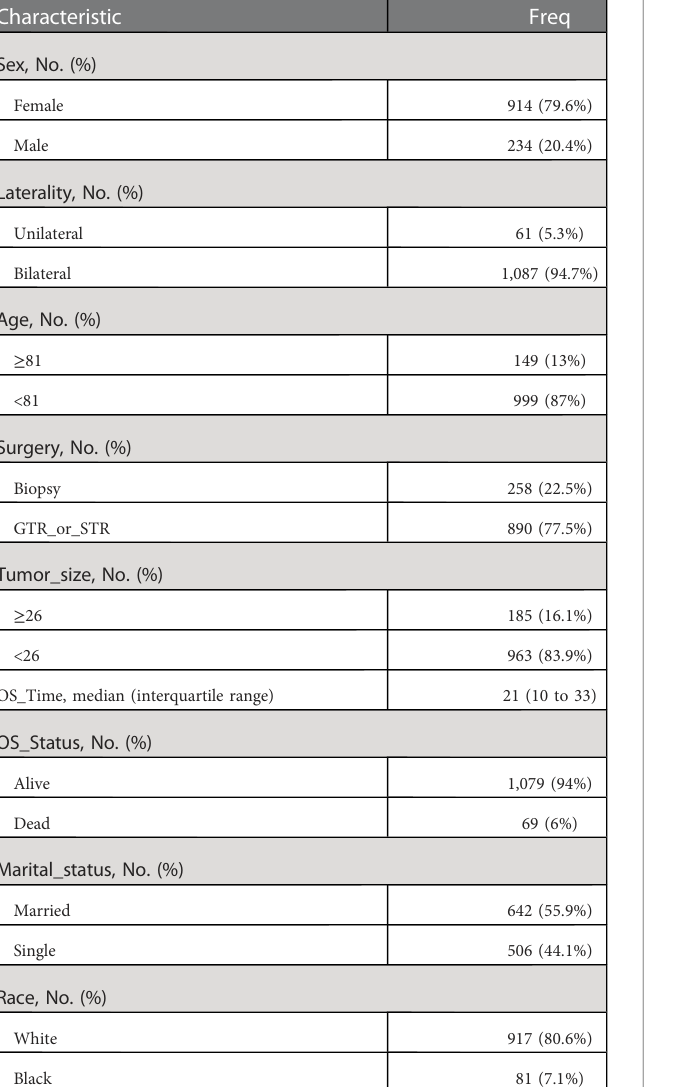
FIGURE 2 Least absolute shrinkage and selection operator (LASSO)